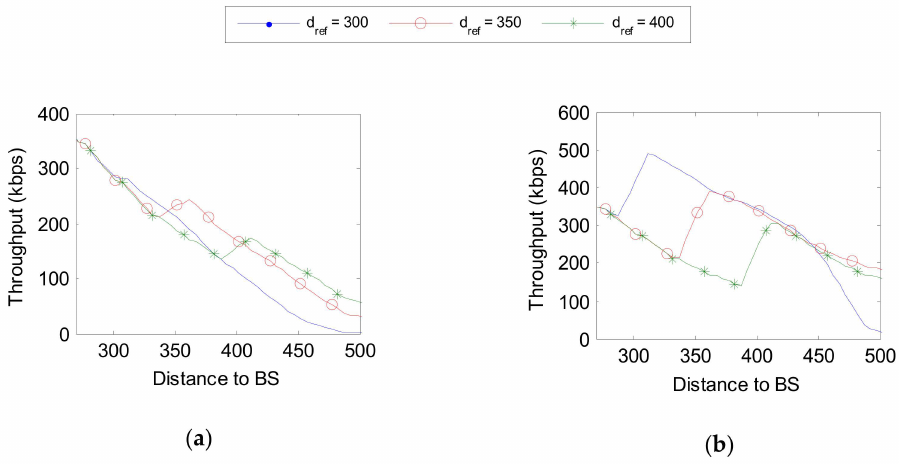
Figure 5. Throughput achieved by the DMS scheme as a function of the distance between DN and BS and d ref : ( a ) 50 RN scenario; ( b ) 400 RN